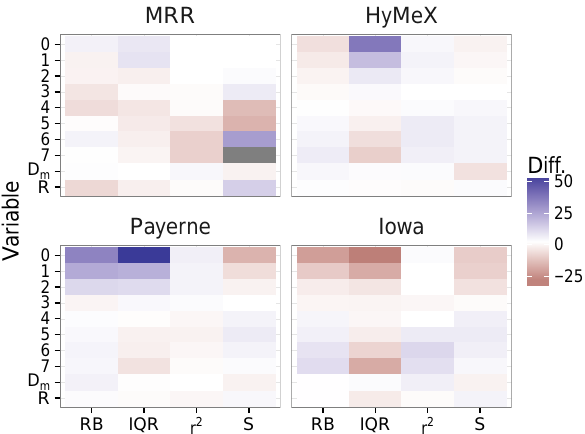
Figure 7. Differences in performance between the double-moment technique and SCOP-ME using noise-corrected radar data, for MRR and for Parsivels by region (differences in Table A4). Vari- ables and performance statistics as for Fig. 4. Red indicates that the double-moment technique outperformed SCOP-ME. Grey indicates an r 2 difference greater than 50 on this scale; these slopes were af- fected by